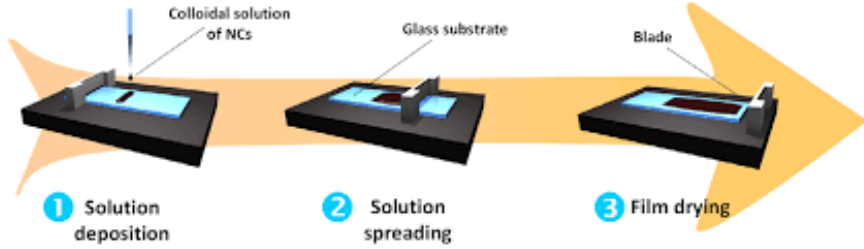
Figure 12. The doctor blade coating process. Reprinted from [125], Copyright 2013 IOP Publishing.